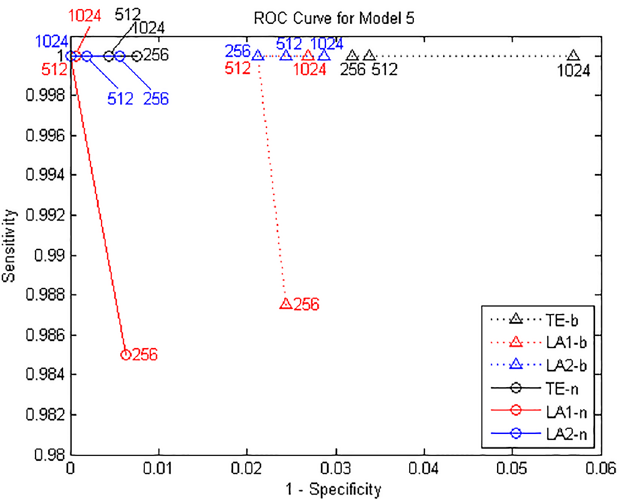
Fig 10. ROC curves for Model E. TE-b/LA1-b/LA2-b are the results by binning entropy estimator and TE-n/LA1-n/ LA2-n by NN entropy estimator, sensitivity and specificity are obtained by gradually increasing the time series length from 256 to 1024